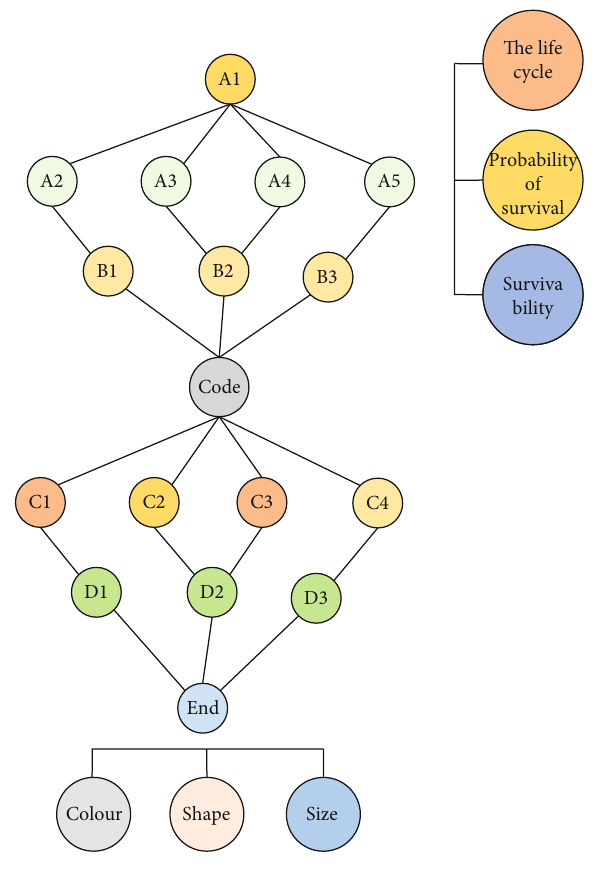
Figure 3: Structural similarity diagram.